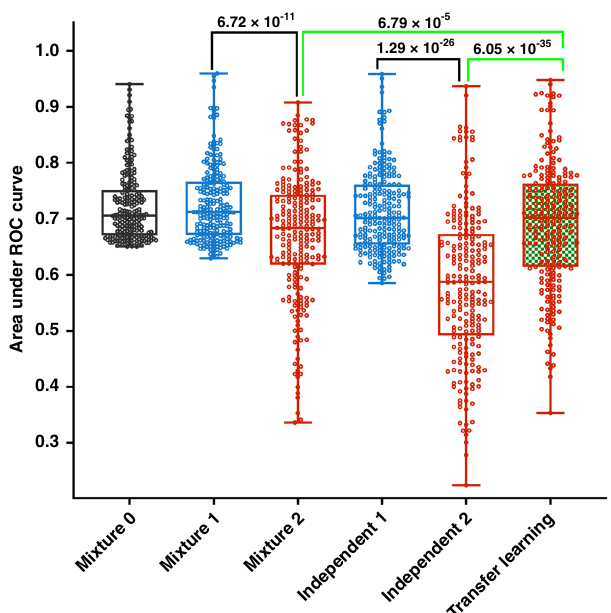
Fig. 2 Performance index values for the multiethnic machine learning experiments. Each box plot shows the AUROC (area under ROC curve) values for the 224 learning tasks for a machine learning experiment listed in Table 1. Each circle represents the mean AUROC of 20 independent runs with different random partitions of training and testing data. The gray color represents performance for the whole cohort, blue represents performance for the EA group, and red represents performance for the AA group. Box- plot elements are: center line, median; box limits, 25 and 75 percentiles; whiskers, the minimum and maximum values. The p values were calculated using one-sided Wilcoxon signed-rank